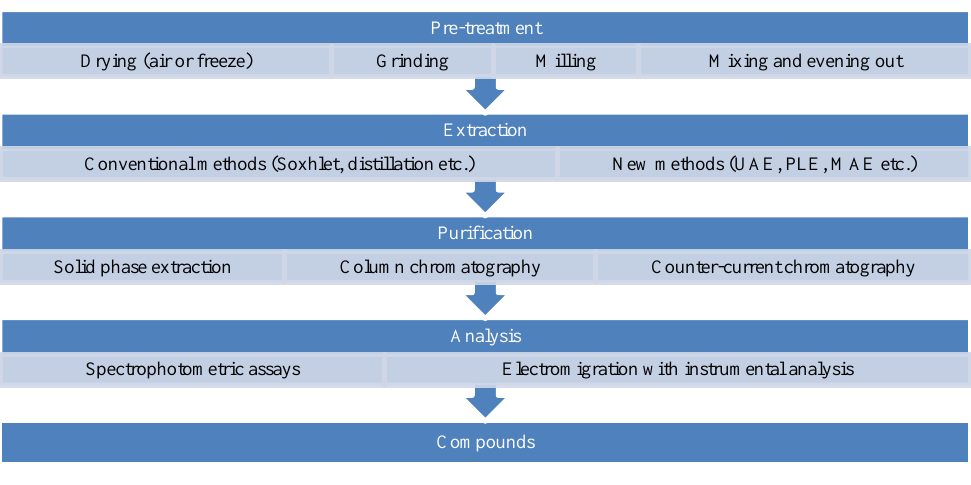
Fig. 1. Preparation of compounds from potatoes